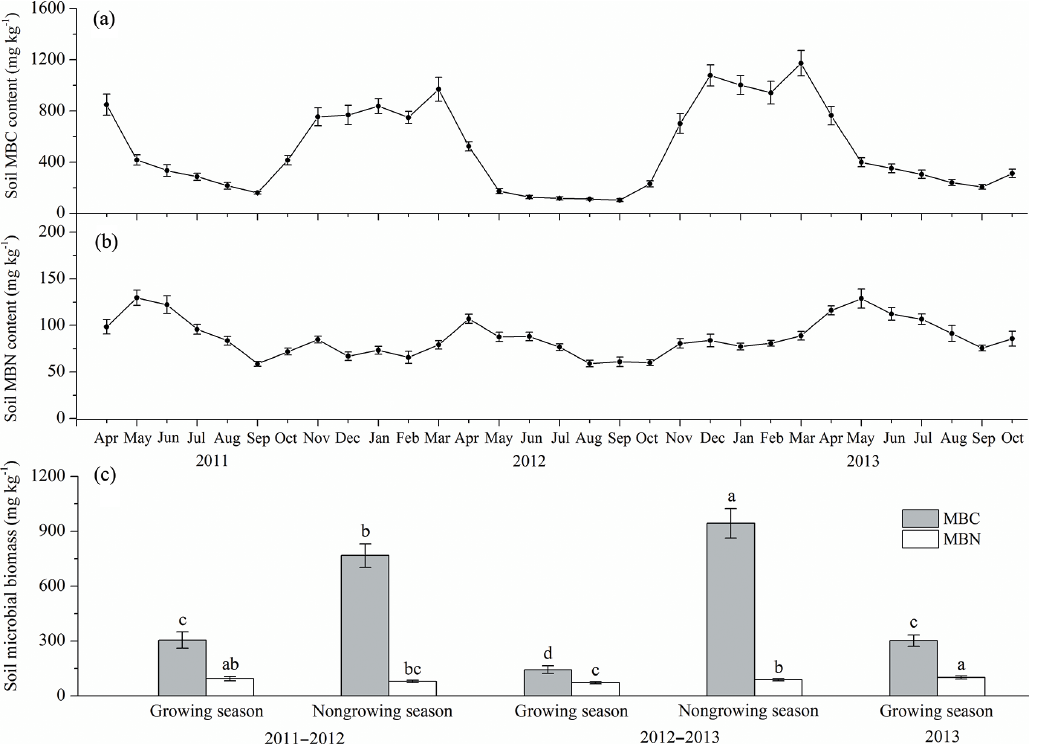
Figure 4. Dynamics of microbial biomass C and N ( a, b ; mean ± SE; n = 15), and their seasonal and interannual differences ( c ; mean ± SE; n = 90) from April 2011 to October 2013 (mean ± SE; n = 90). The sampling time was on the 15th day of each month during the growing season from May to October, and during the nongrowing season from November to April of the following year. Seasons and years were compared using two-way ANOVA, and different lowercase letters indicate significant differences of the interaction effects between season and year determined via Duncan’s test ( p <